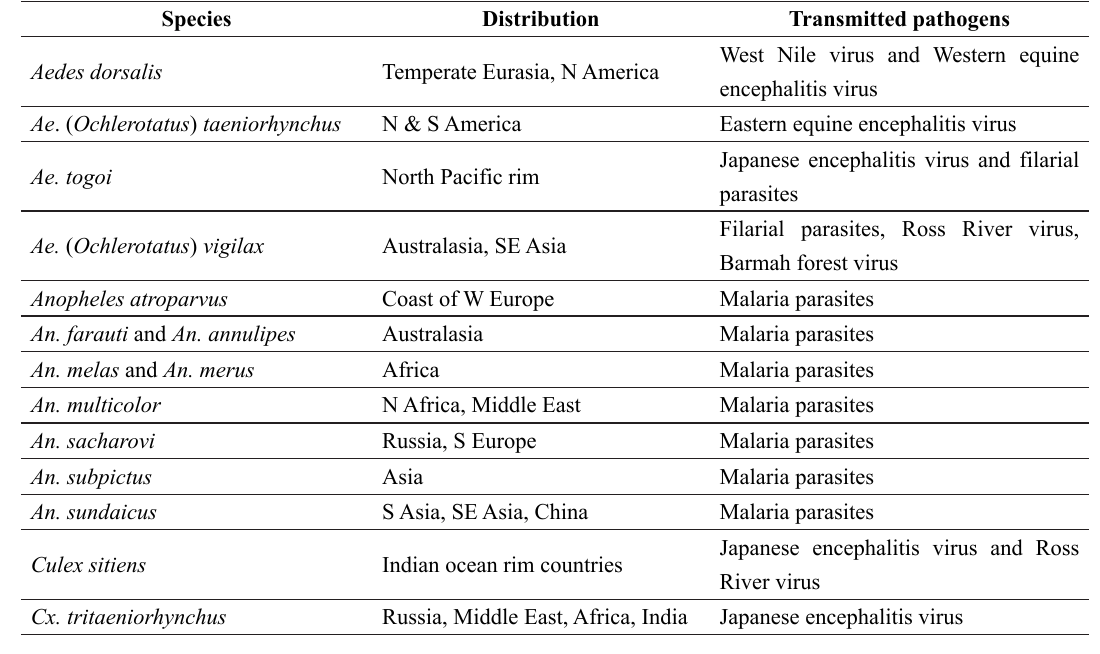
Table 2: Common salinity-tolerant mosquito vectors of human disease. (adapted from Ramasamy and Surendran, 2011 and